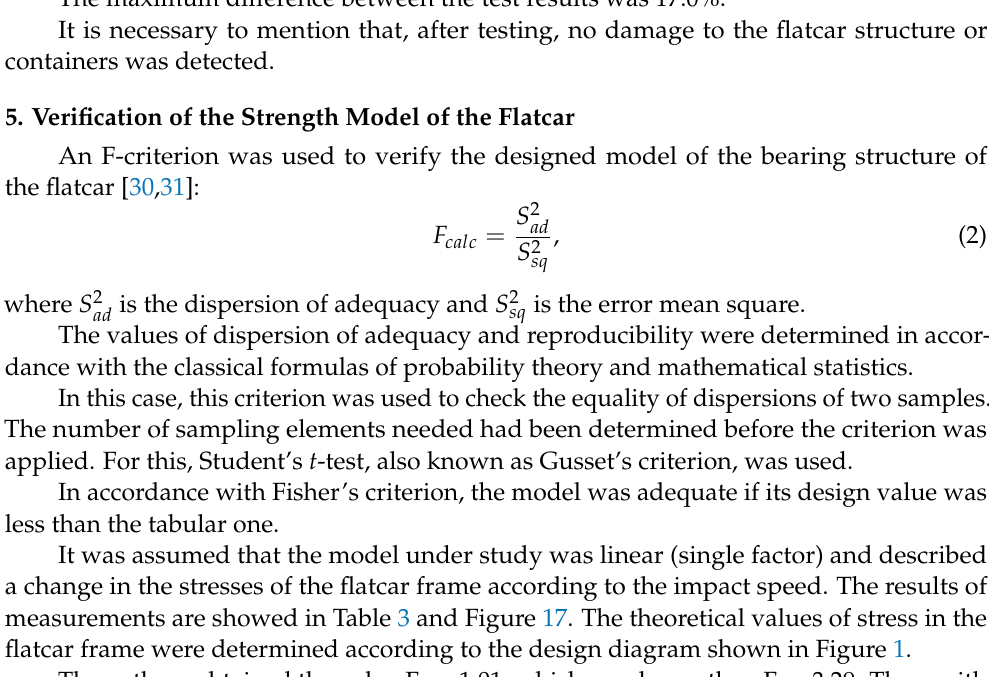
Table 3. The stresses in the flatcar frame during a collision (strain gauge 5) . Impact Speed, km/h